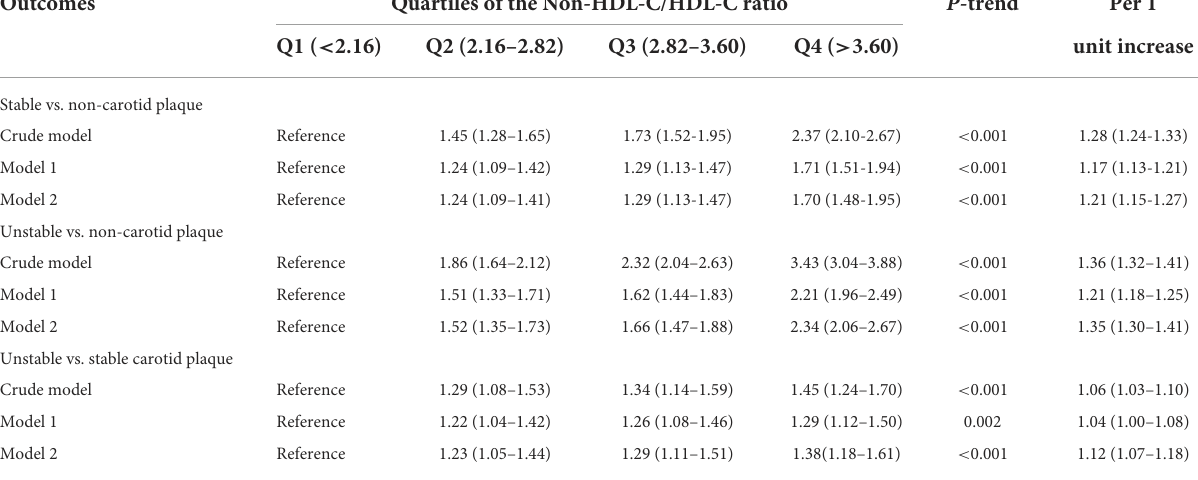
TABLE 2 Multinomial logistic odds ratios ( ORs ) (95% CI ) of the association of the non-HDL-C/HDL-C ratio with carotid stability.